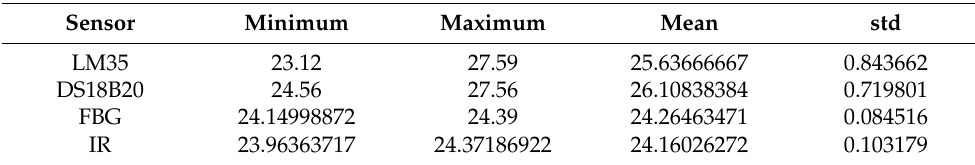
Table 3. Statistics of the measurements of all sensors for charging the battery.